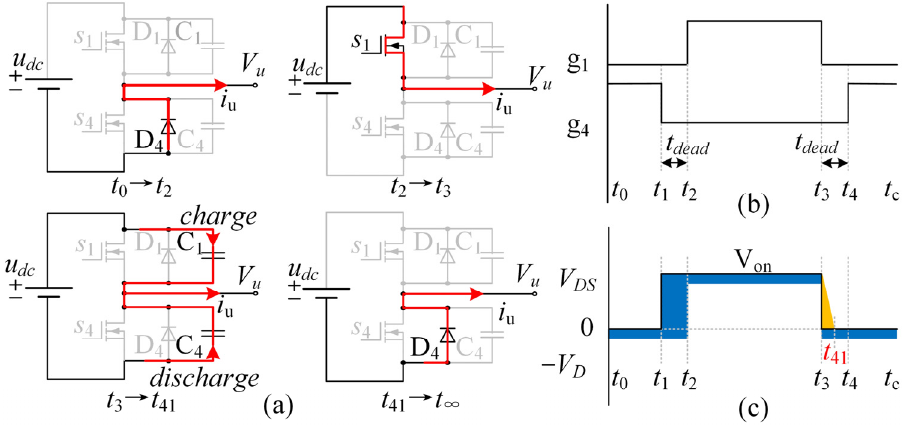
Figure 1. The deadtime effect considering the parasitic capacitance under positive current. ( a ) The equivalent circuit. ( b ) The gate signal. ( c ) The drain-to-source voltage.